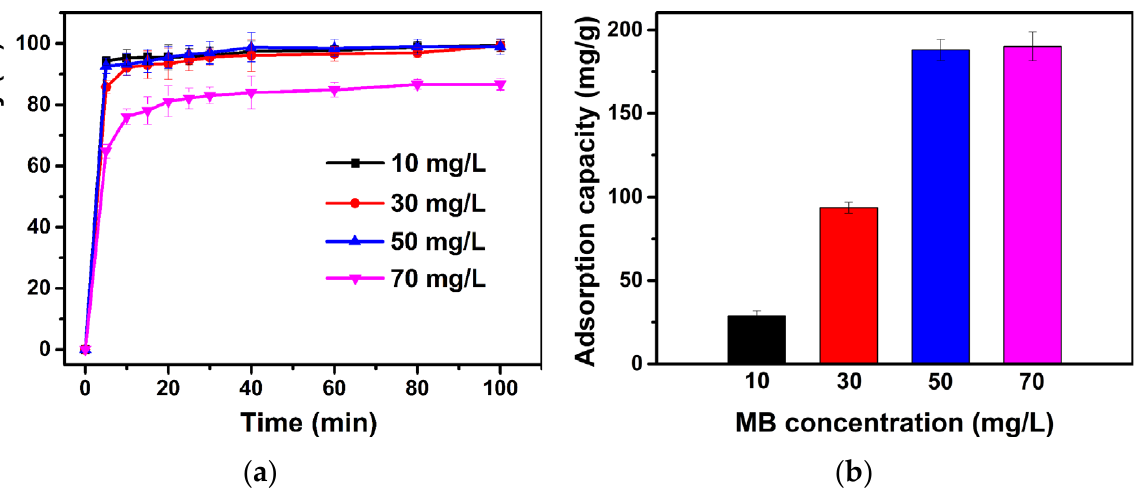
Figure 13. Effects of initial concentration on the removal efficiency ( a ) and adsorption capacity ( b ) of methylene blue over Sample SA - E .